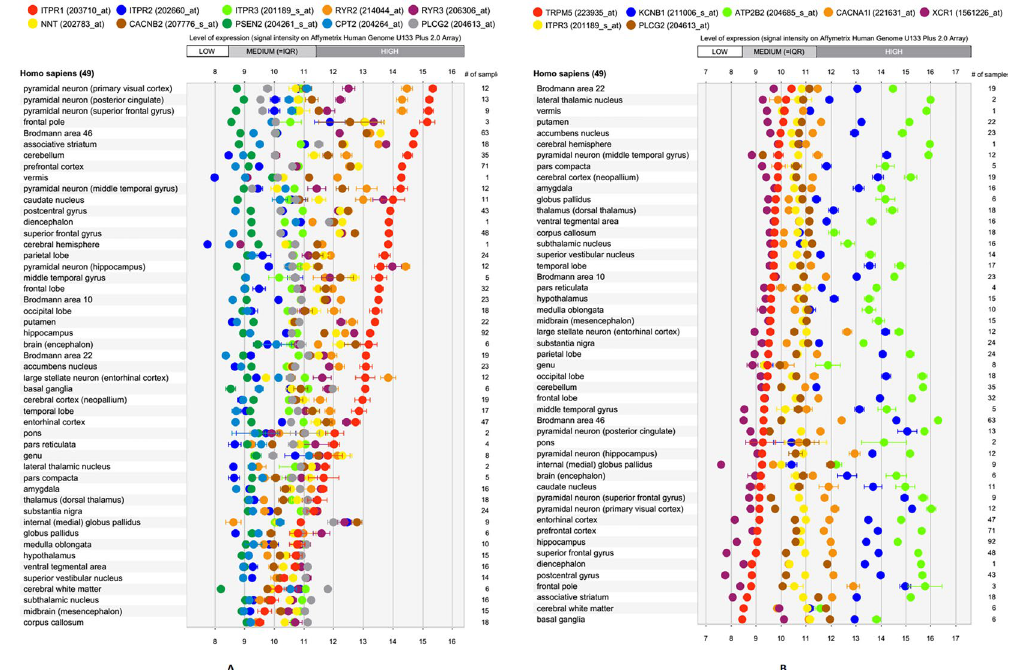
Figure 4. The relative expression levels of mutated ion transport genes in FtMs ( A ) and MtFs ( B ) in healthy brain tissue were identified using the GENEVESTIGATOR